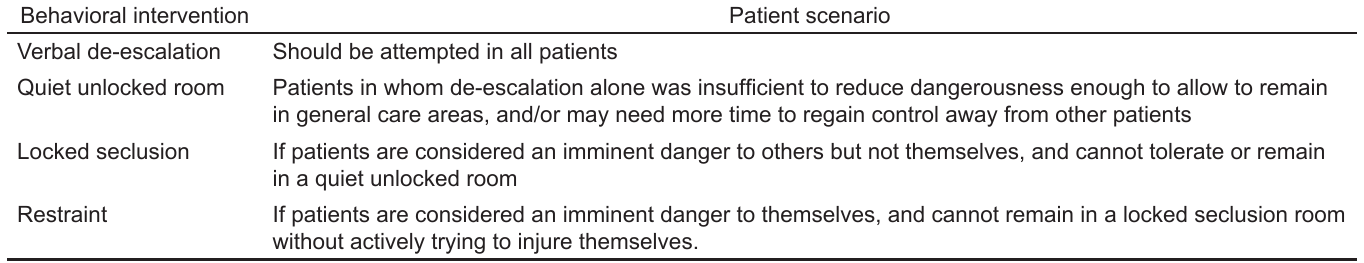
Table 1. Behavioral interventions for different scenarios involving patient agitation.